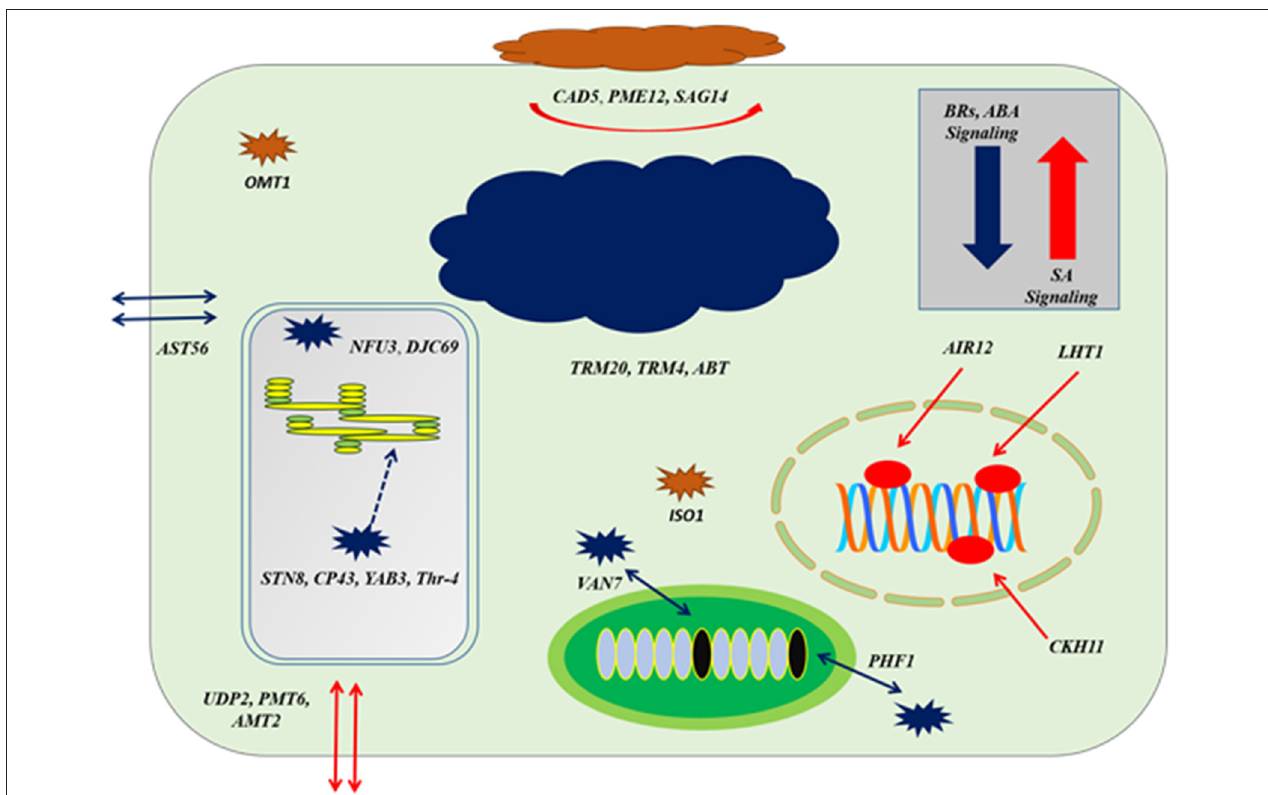
FIGURE 8 | The cellular response at genes co-expression of auxins signaling gene ( TIR1 ) based on Figure 7 ; at the level of upregulation TIR1 , deposition of cell wall materials of upregulated genes, such as CAD5, PME12, and SAG14 with the cell-specific transporters, such as UDP2, PMT6, and AMT2 increased. The enzymatic reactions of flavonoids degradation ( ISO1 ) and ROS productions ( OMT1 ) were also increased proliferating microbial growth. During downregulation of TIR1, genes regulating photosynthetic rate and thylakoid organization, such STN8, CP43, YAB3, and Thr-4, VAN7, and PHF1 for mitochondrial organization and TRM20, TRM4, and ABT were downregulated, deterring cellular growth. Regarding other phytohormonal signaling, ABA and BR signaling systems were reduced while SA signaling was